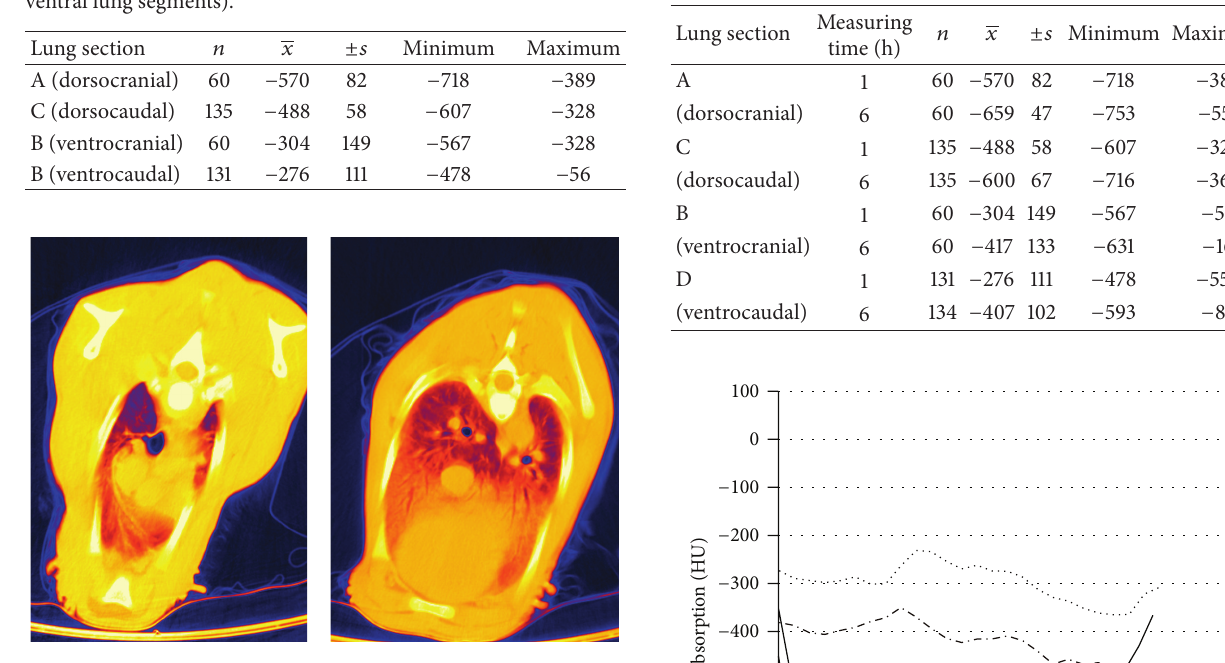
Figure 1: CT: thorax layer in false-color representation of a subject of group A at 1 hour p. n.